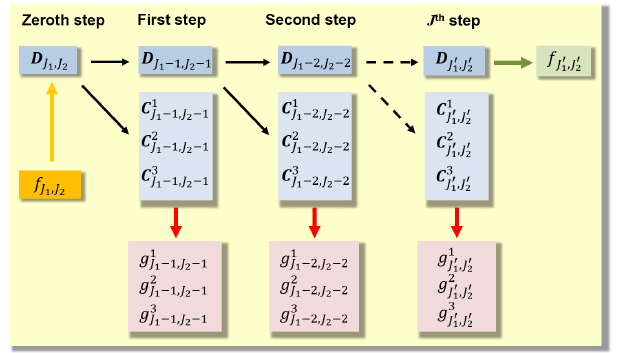
Figure 5. A 2-D MSR of the signal f J